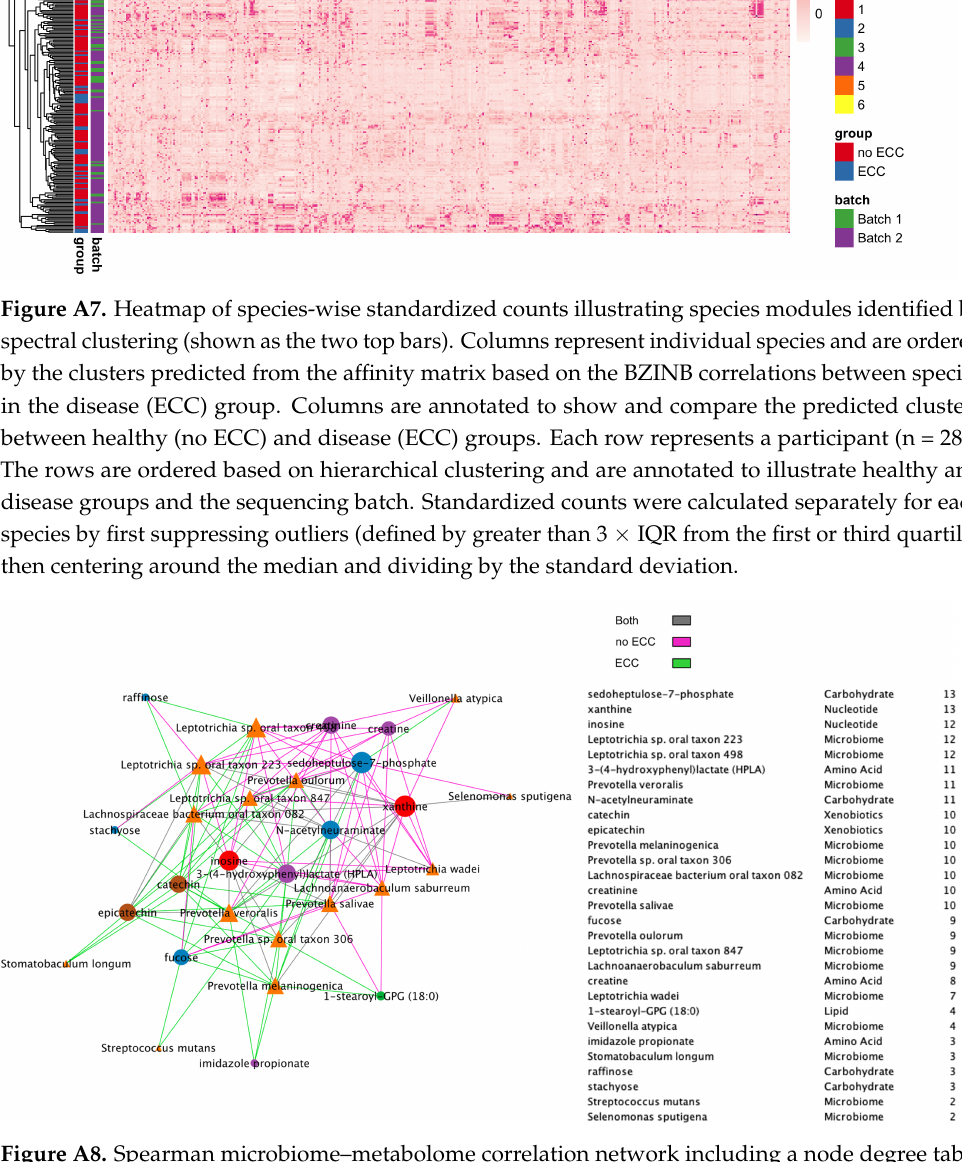
Figure A8. Spearman microbiome–metabolome correlation network including a node degree table. The strongest 30% absolute correlations are illustrated. Line colors represent correlations’ strength in health, disease (ECC), or